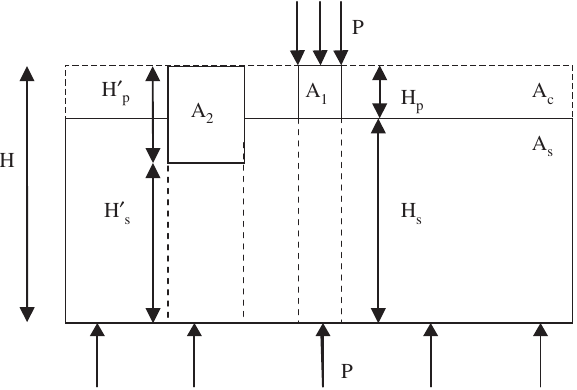
Figure 1: Schematic of a micropillar compression